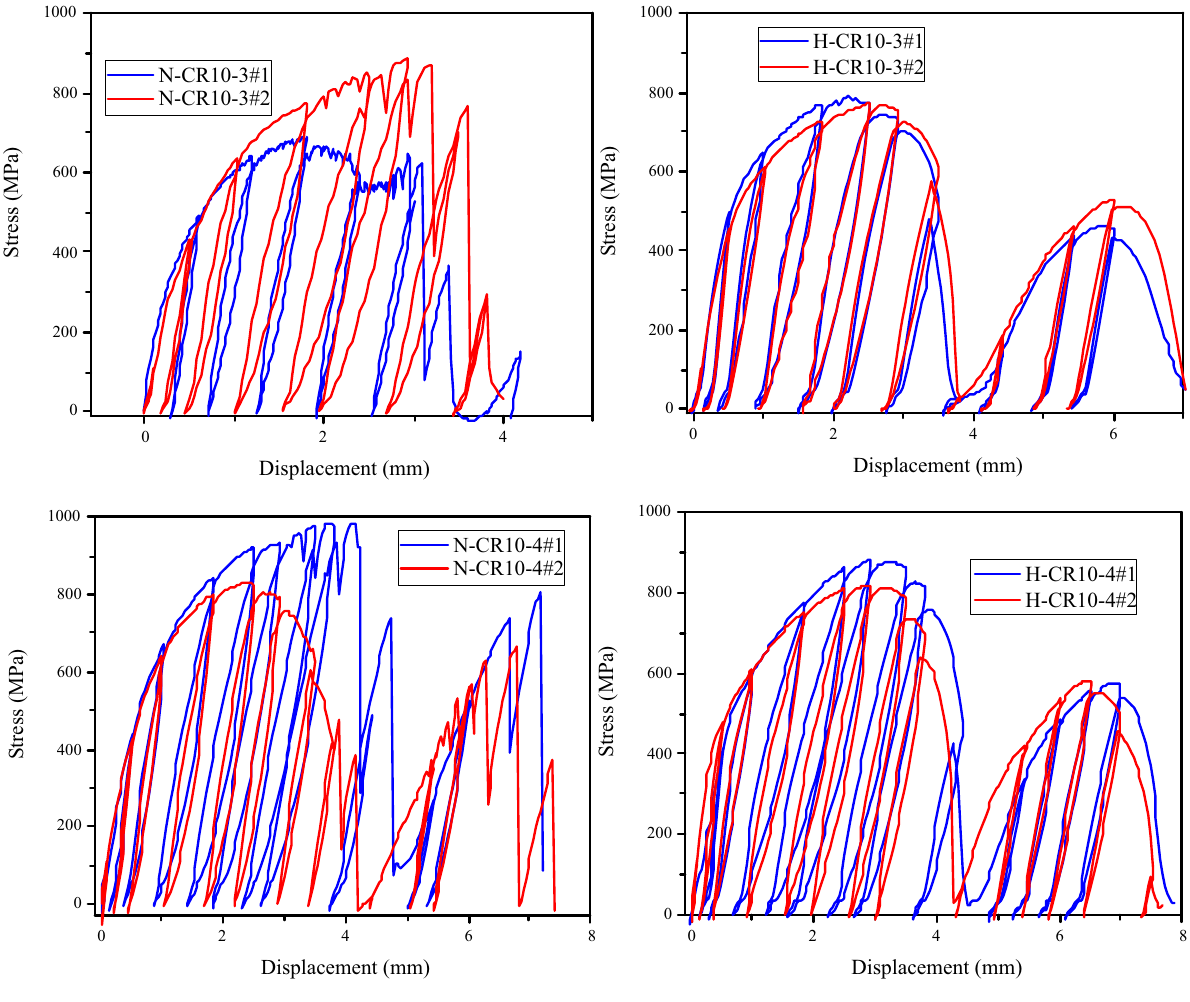
Figure 5: Pullout response of crimped fi ber with 1.0 mm diameter.